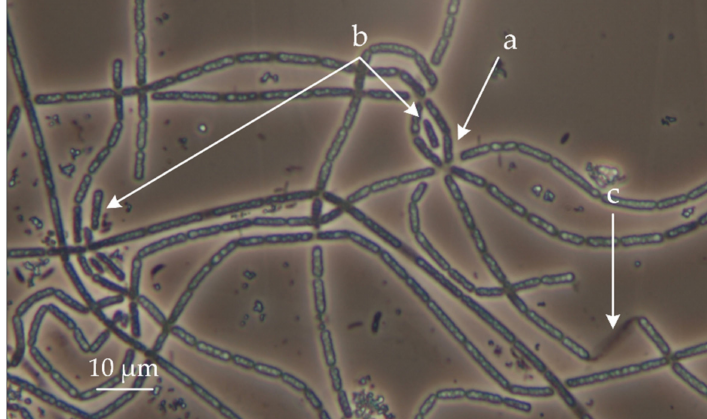
Figure 1. Thiothrix sp. as part of a phosphate-accumulating microbial community. Arrows show cells forming rosettes ( a ); detached cells that serve for reproduction (gonidia) ( b ); a sheath ( c ). Cell morphology was observed by using an Olympus CX 41 microscope equipped with a phase-contrast